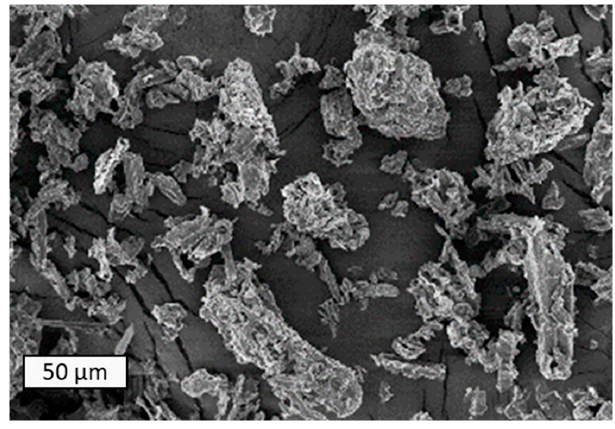
Figure 4. Powder ground with #0.2 rasp screen to a median size of 30 μ m. Magnitude 1000×.